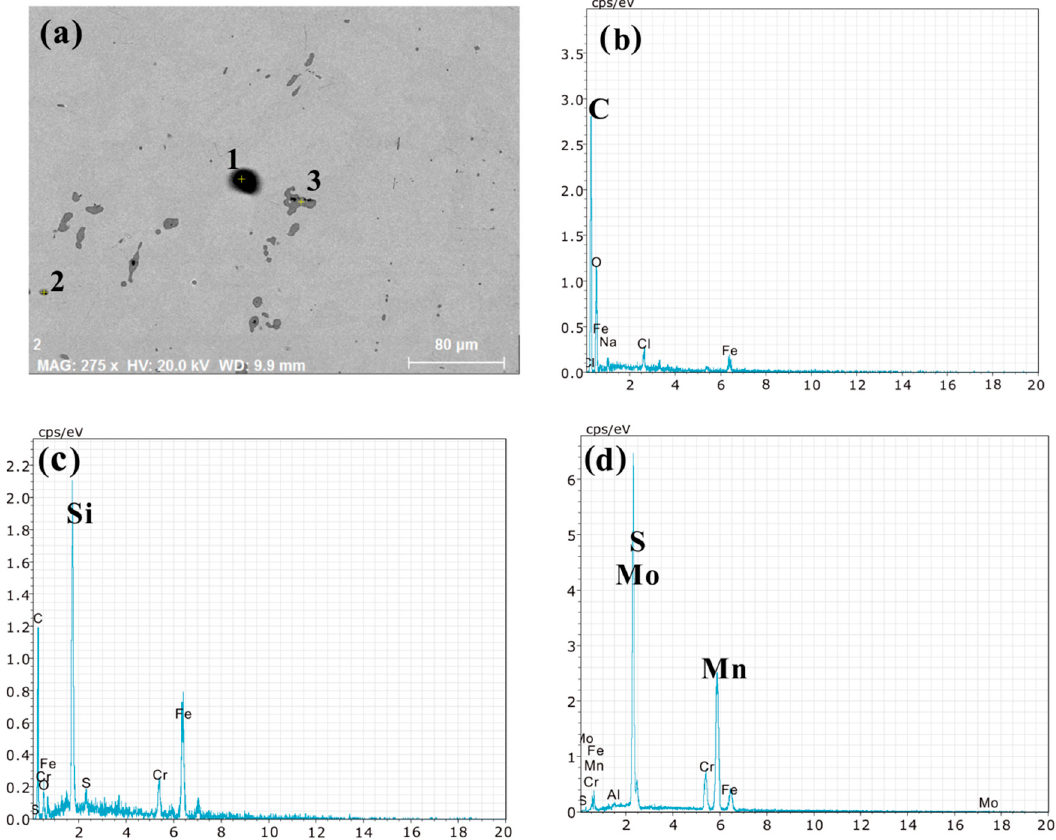
Figure 8. Heterogeneous phases in1Cr13MoS material, ( a ) SEM image of 1Cr13MoS material (Backscattered electrons, Acceleration voltage: 20 kV, Working distance: 9.9 mm), ( b) , ( c) , ( d) correspond to the EDS of the inclusions at 1, 2, and 3 in Figure 8a, respectively.